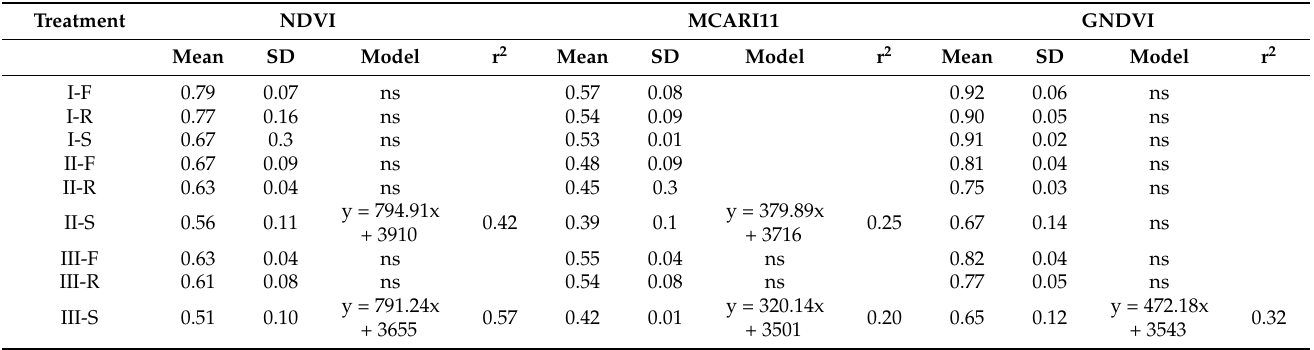
Table 7. Mean vegetation indices and yield prediction for common bean under different irrigation treatments and sowing